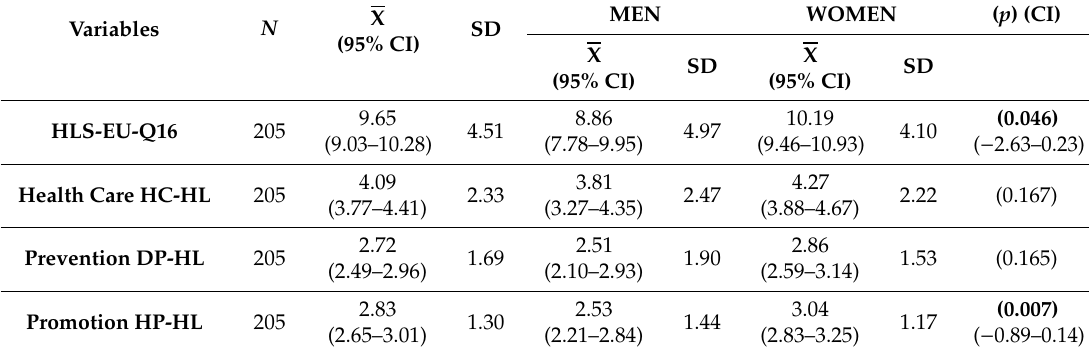
Table 3. HLS-EU-Q16 (European Health Literacy Survey Questionnaire) scores.